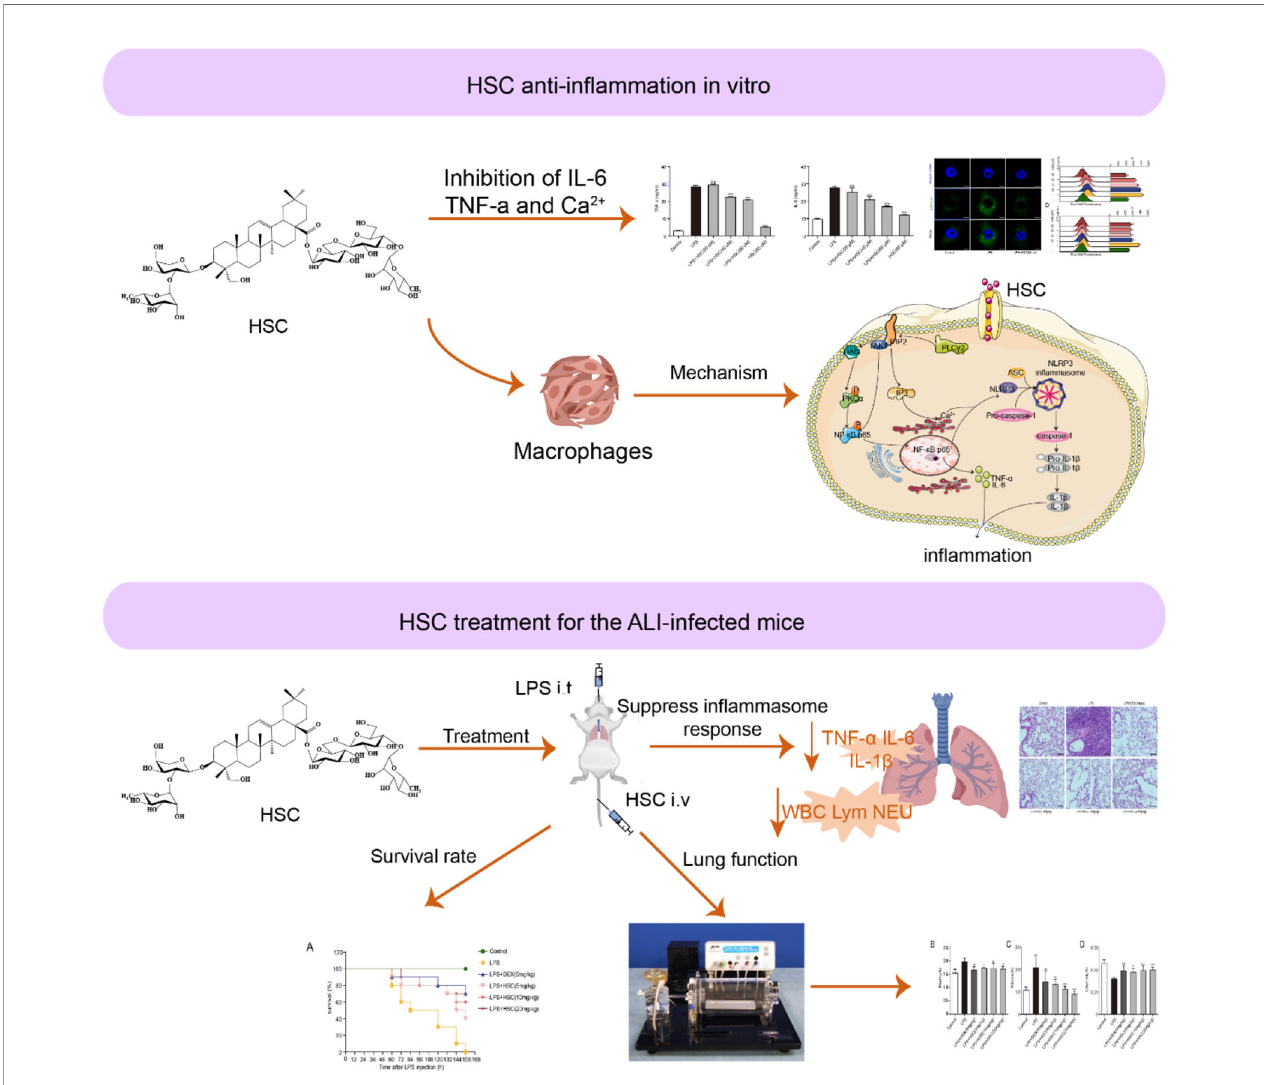
FIGURE 11 | Working model for the HSC-based therapeutic effect of